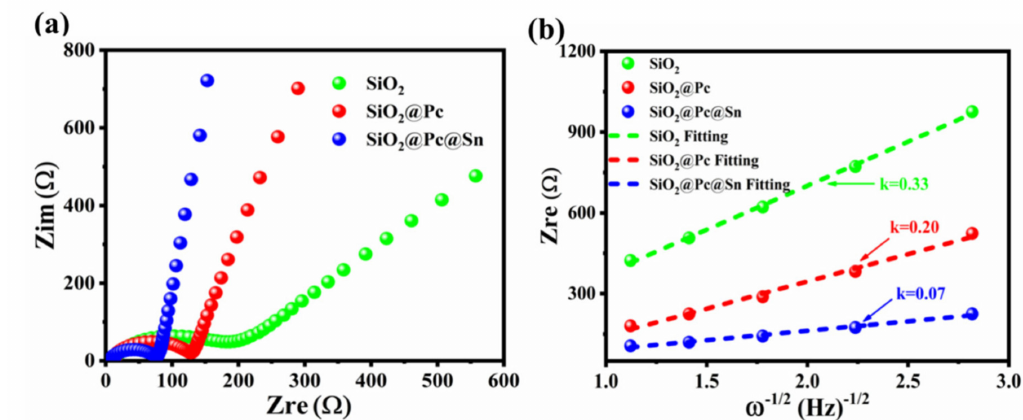
Figure 5. ( a ) Comparison for the Nyquist diagram of different samples; ( b ) impedance real part Z re Vs w − 1/2 in the frequency range 1–0.1 Hz.